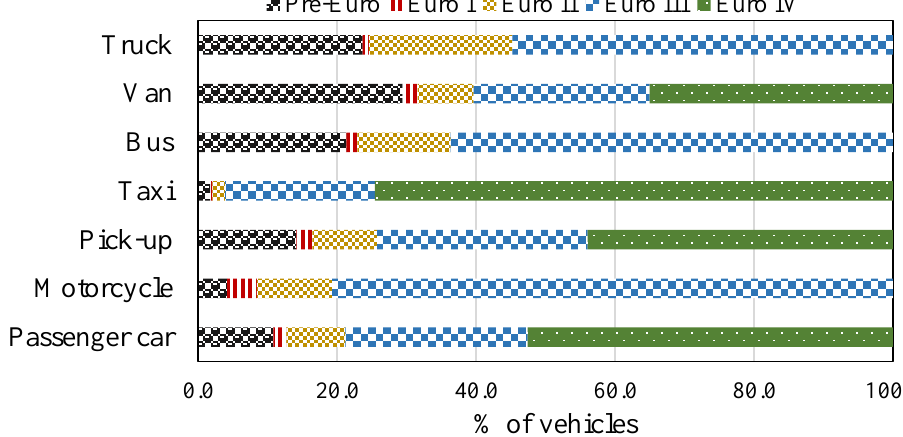
7 of 15 Figure 3. Proportion of different vehicle types on roads with different number of lanes in Bangkok . The engine technology of vehicles on the roads was estimated using the enforcement dates of different emission regulations and vehicle registration data from the Department of Land Transport (DLT) in Thailand. It was assumed that vehicles which were registered after the enforcement date for the latest vehicle emission standard in Thailand would fol- low that emission regulation (Table 2). The proportion of different vehicle types on the road was estimated using data for registered vehicles by age from the DLT (Figure 4). It was assumed that the proportion of different standard vehicles on the road was similar to that from the DLT registration data. Table 2. Vehicles ages with different European emission standards in Thailand . Vehicle Type Vehicle Ages with different European Standards in Thai- land (Years) Pre-Euro